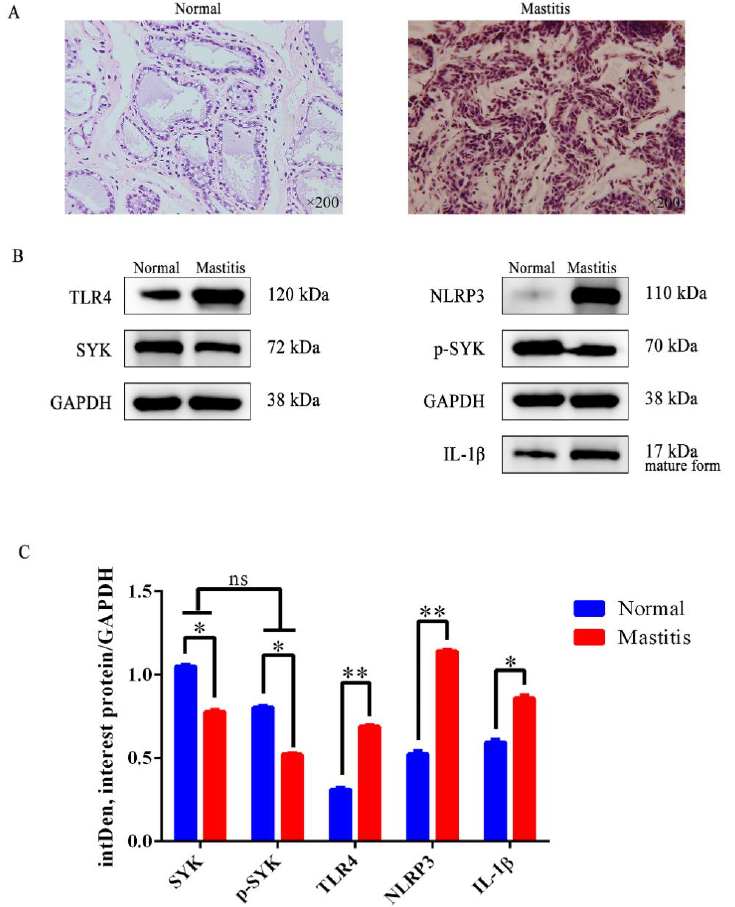
Figure 2. TLR4, SYK, p-SYK, IL-1 β and NLRP3 protein levels in bovine normal mammary gland and mastitis tissues (3 normal cows and 3 mastitis cows). ( A ) Morphological differences in normal bovine mammary gland and mastitis tissue (H&E staining); ( B ) TLR4, SYK, p-SYK, IL-1 β and NLRP3 levels were detected in bovine normal mammary gland and mastitis tissues via the WB method; ( C ) the relative quantitative method of intDen value to calculate the difference of TLR4, SYK, p-SYK, IL-1 β and NLRP3 levels in bovine mammary gland and mastitis tissues. * p < 0.05, ** p < 0.01, ns = no difference.